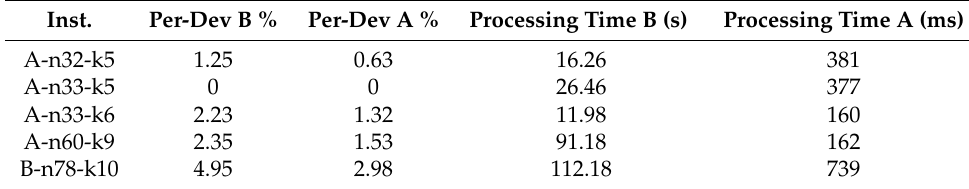
Table 3. The obtained co-simulation result of models M 1 with M 1